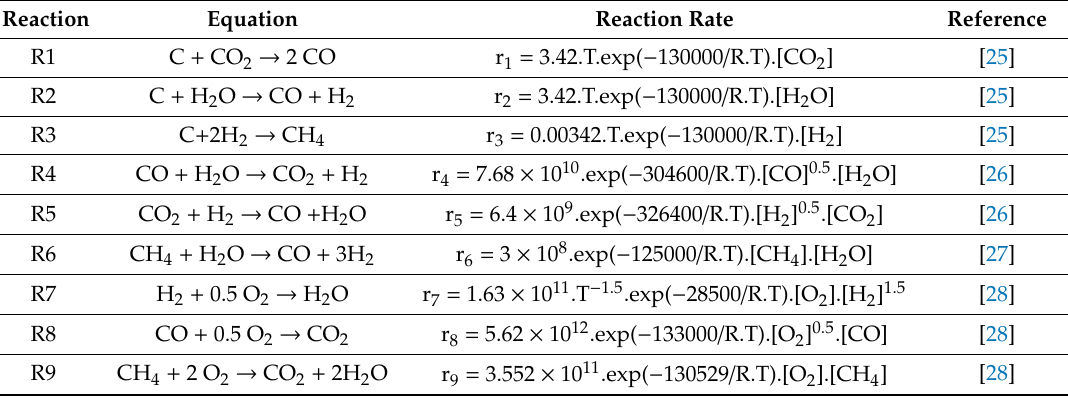
Table 2. Kinetic of involved reactions.